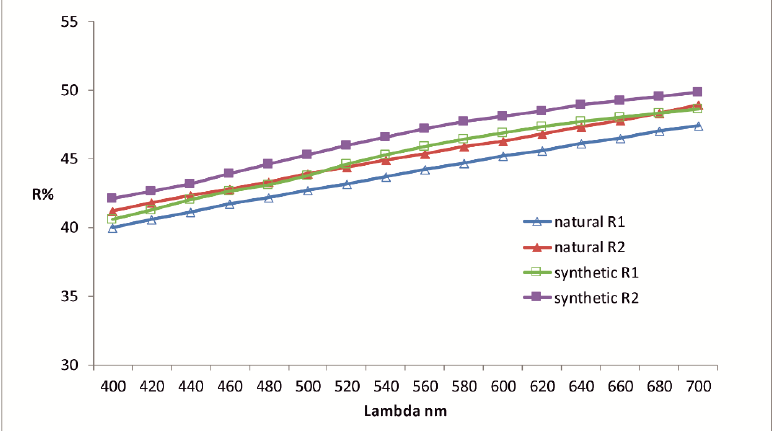
Figure 2. Reflectance data for thalhammerite compared to synthetic analogue, in air. The reflectance values (R%) are plotted versus the wavelength λ in nm.